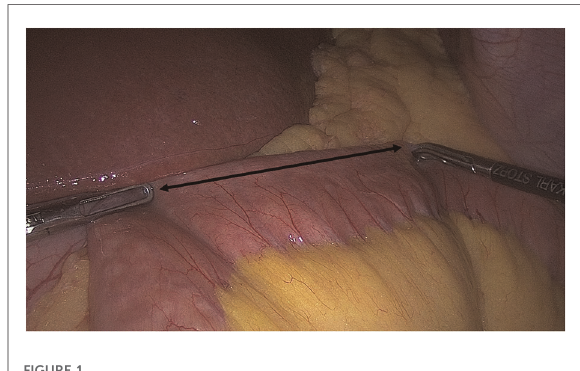
FIGURE 1 Image quiz marking 8 cm of jejunum was sent to